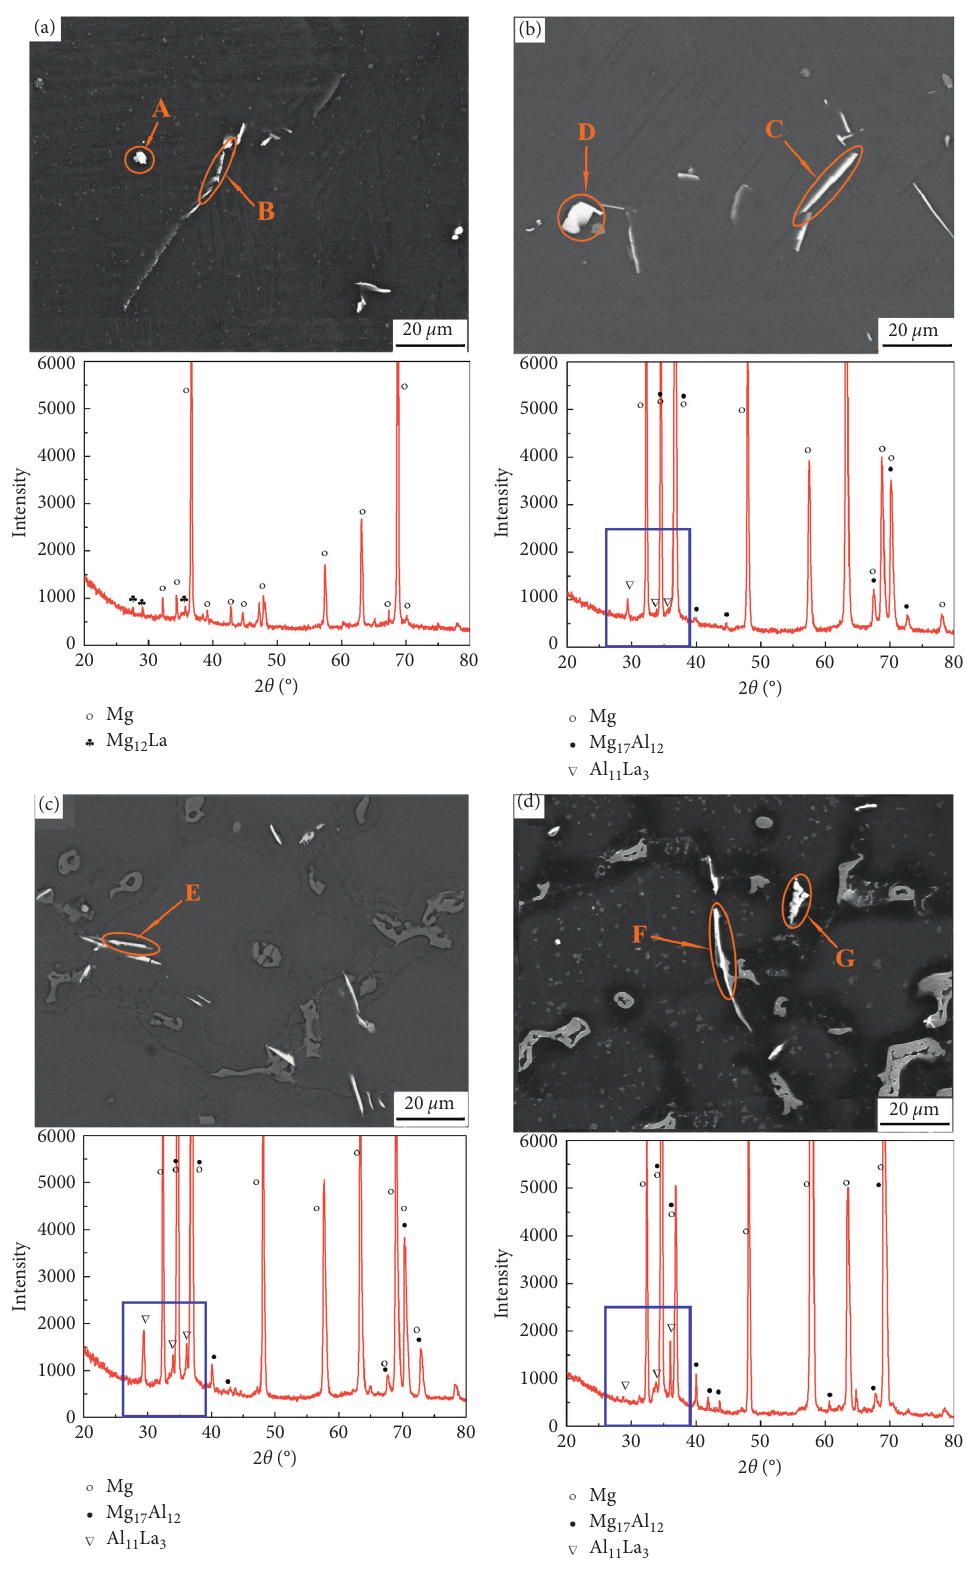
Figure 2: SEM images and XRD patterns of as-cast studied alloys: (a) AZ01-0.3La; (b) AZ31-0.3La; (c) AZ61-0.3La; and (d)